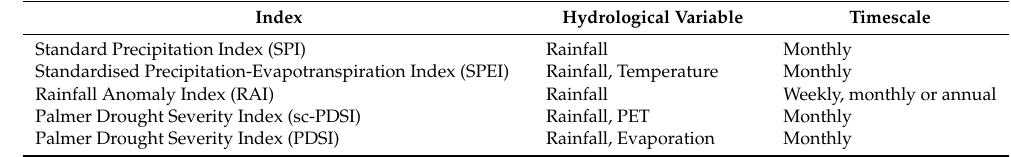
Table 1. Indices and linked